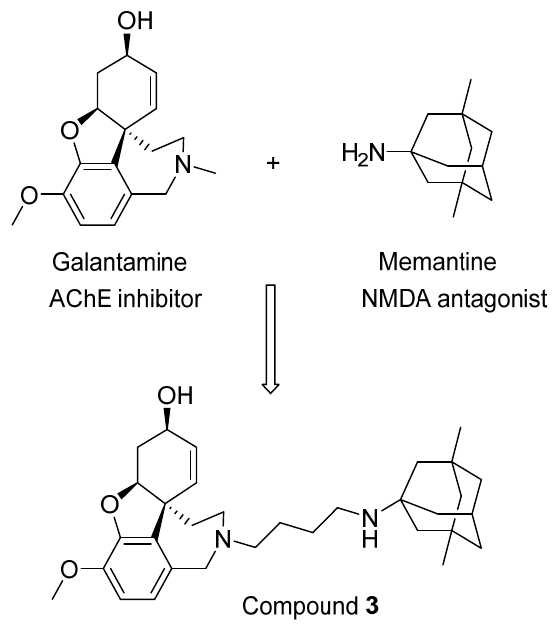
Figure 3. Linking two FDA-approved drugs leads to a new bifunctional drug